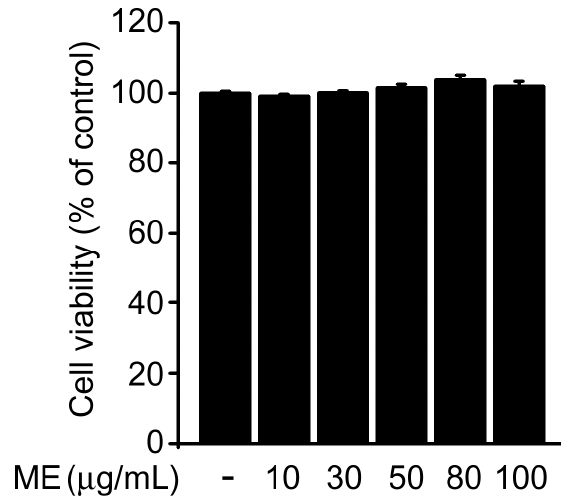
Figure 1. Cytotoxicity test of Melandrii Herba extract. Cells were exposed to the indicated concentrations of Melandrii Herba extract for 24 h. Cell viability was tested by MTT assay.